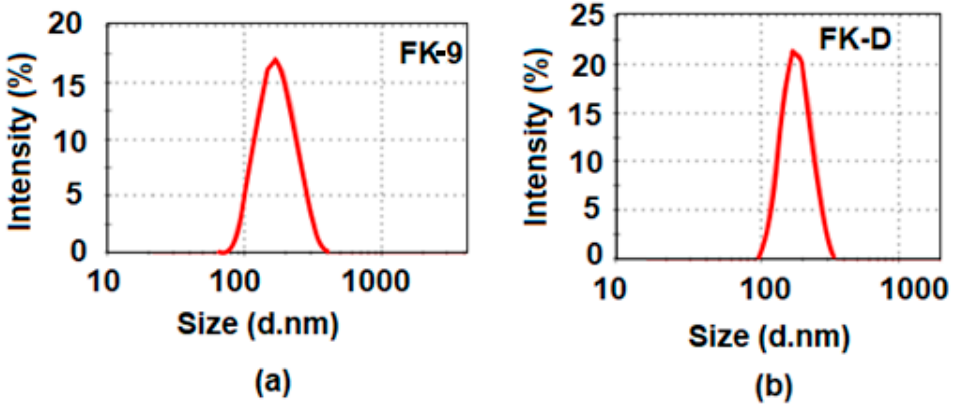
Figure 4. Particle size distributions of ( a ) blank optimized nanoemulsion (FK-9) and ( b ) Amp B drug-loaded formulation (FK-D) in PCL polymer nanoparticles.